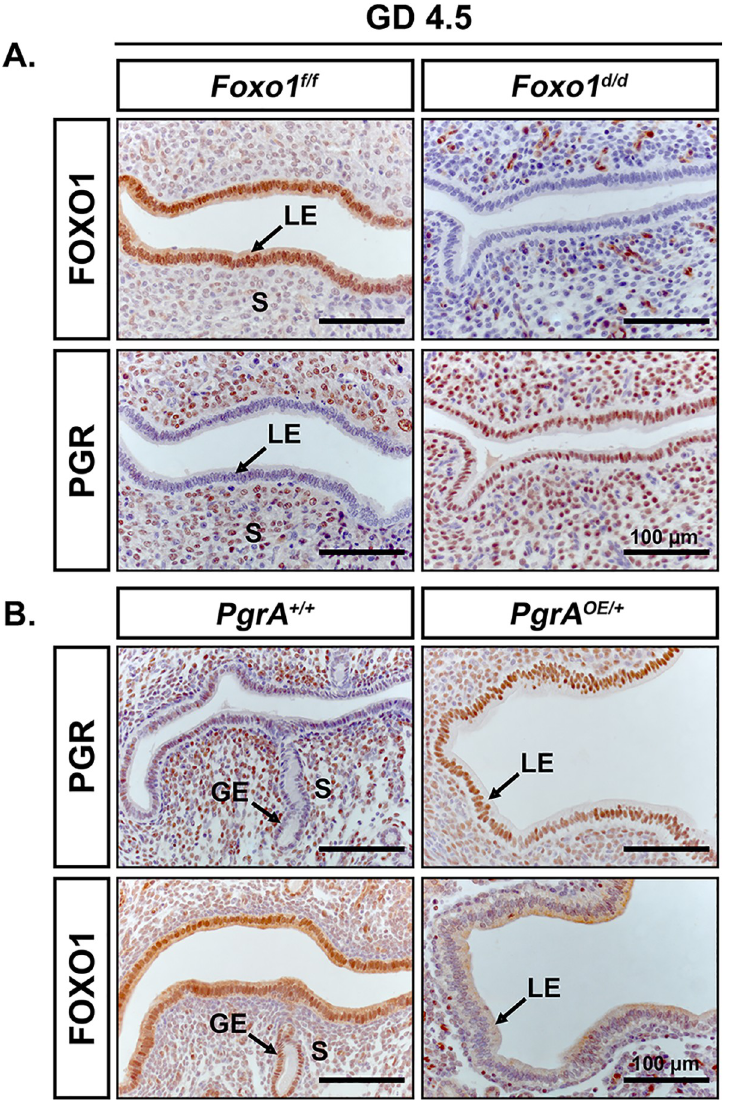
Fig 6. Mutually controlled balance of epithelial PGR and FOXO1 governs the WOR. Immunohistochemical staining for FOXO1 and PGR in the cross sections of Foxo1 f/f and Foxo1 d/d murine uteri at GD 4.5 ( A ), as well as, PGR and FOXO1 in the cross sections of PgrA +/+ and PgrA OE/+ murine uteri at GD 4.5 ( B ). LE, luminal epithelium; S, stroma. Scale bar, 100 μ m.